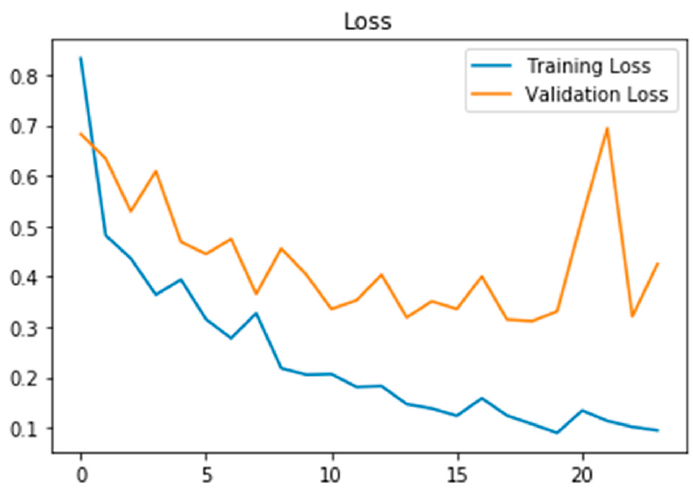
Figure 9. Training and validation loss for the first 20 epochs with a stable difference in training and validation loss showing a good fit curve.